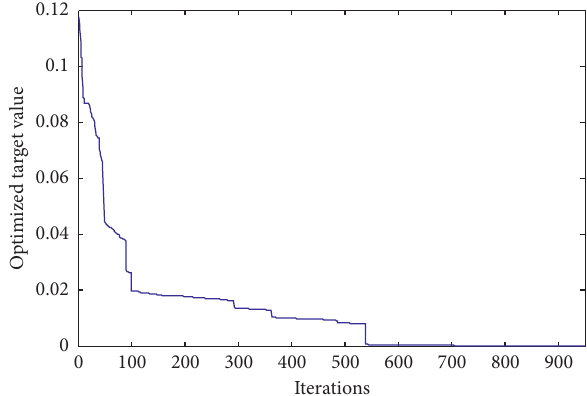
Figure 11: Optimization curve of the optimal objective